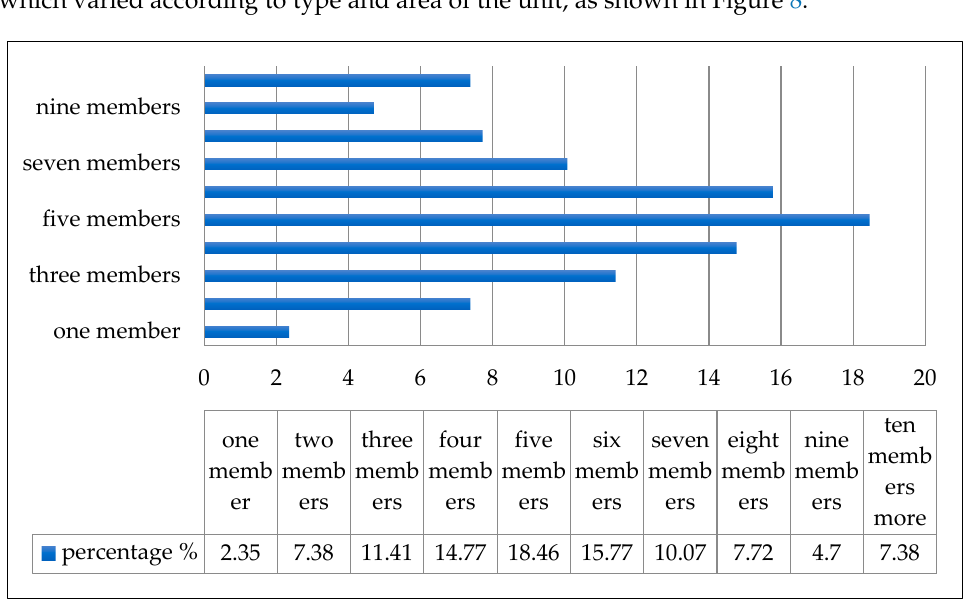
Figure 8. The number of rooms in each residential unit. 3.3. Occupant Behaviour under Pandemic Conditions The study also analyzed the behaviors of the occupants, along with the ability of the residential designs to meet the need for social distancing and self-isolation in the event of positive cases of COVID-19. This included direct questions to respondents, as well as their user profile in terms of each unit. •